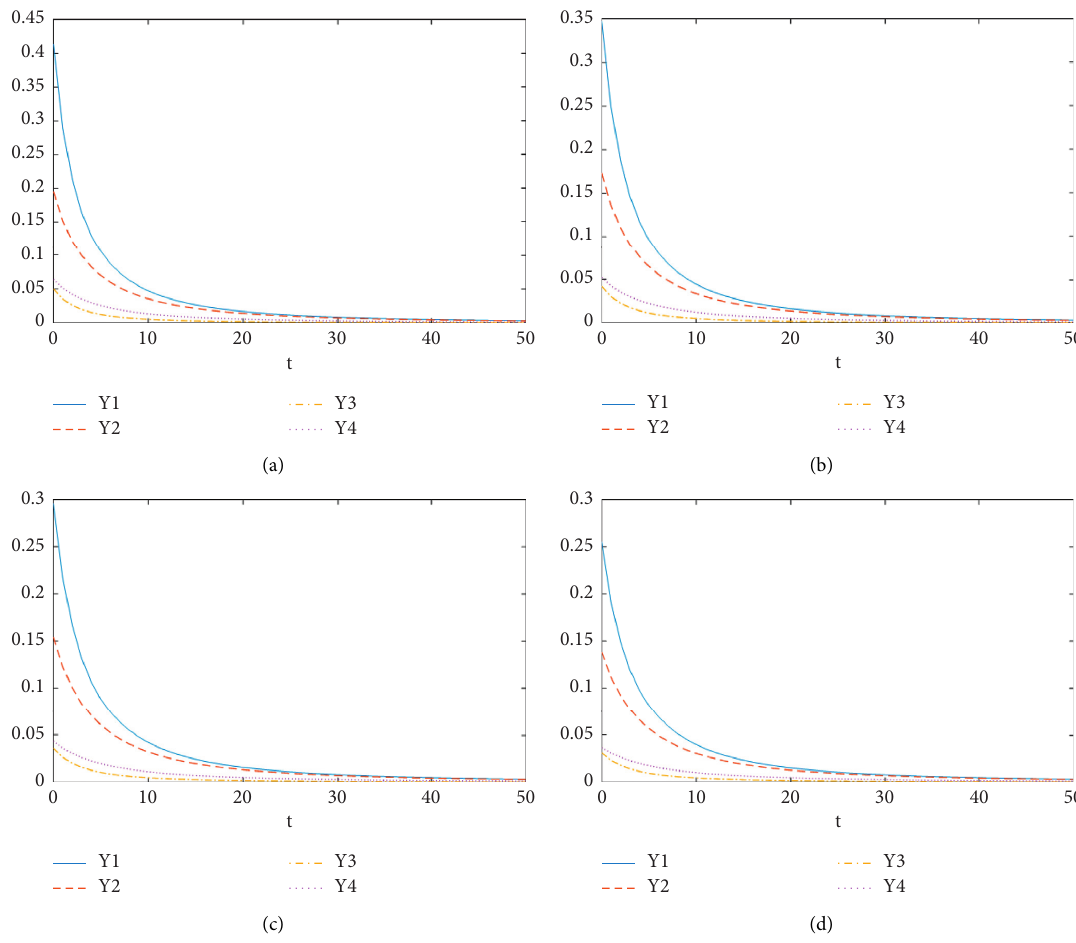
Figure 1: Optimal carbon emissions under different parameter values ( s